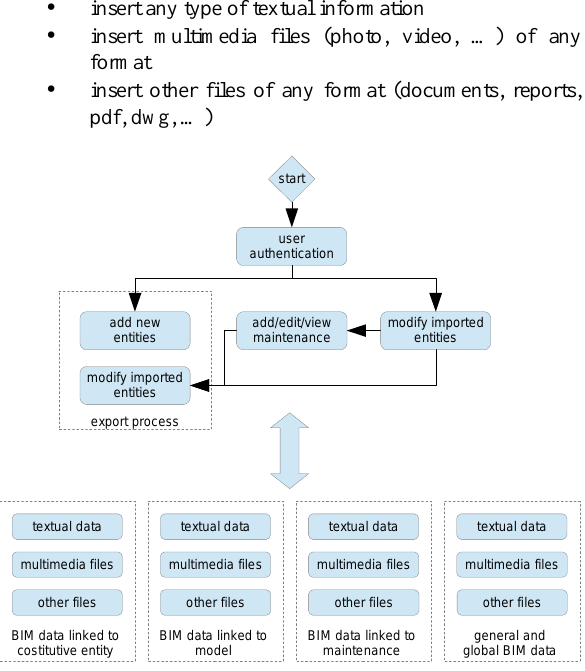
Figure 1. block schema for the main features of BIM3DSG.